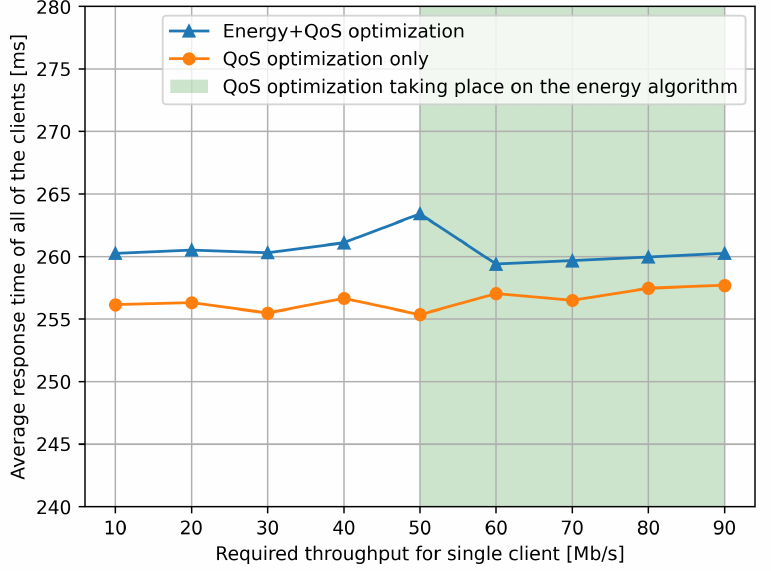
Figure 8. We observe the very significant stability of the average response time of the system over a long period of 500 s, when either QoS optimization is, or QoS and energy optimization are conducted by the RL-based control algorithm. This illustrates the ability of the RL control to react to changes in load represented by ongoing requests by the clients to the services, maintaining the average response time at a low level. We see that the reduction in power consumption observed in Figure 7 comes at an increase of less than 2% (5 parts in 250) in the average response